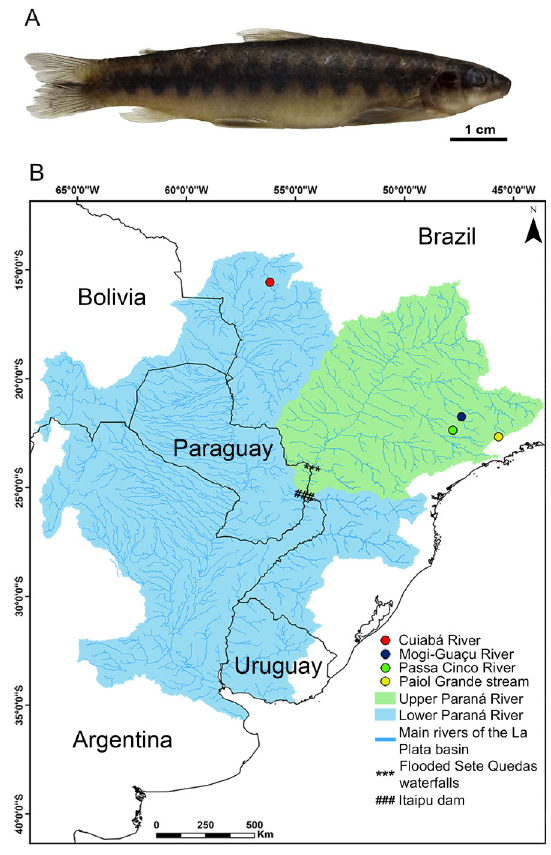
FIGURE 1 | A. Adult specimen of Parodon nasus . B. Partial map of the South America showing the La Plata basin, the principal rivers of the basin, and the collection sites of the P. nasus species